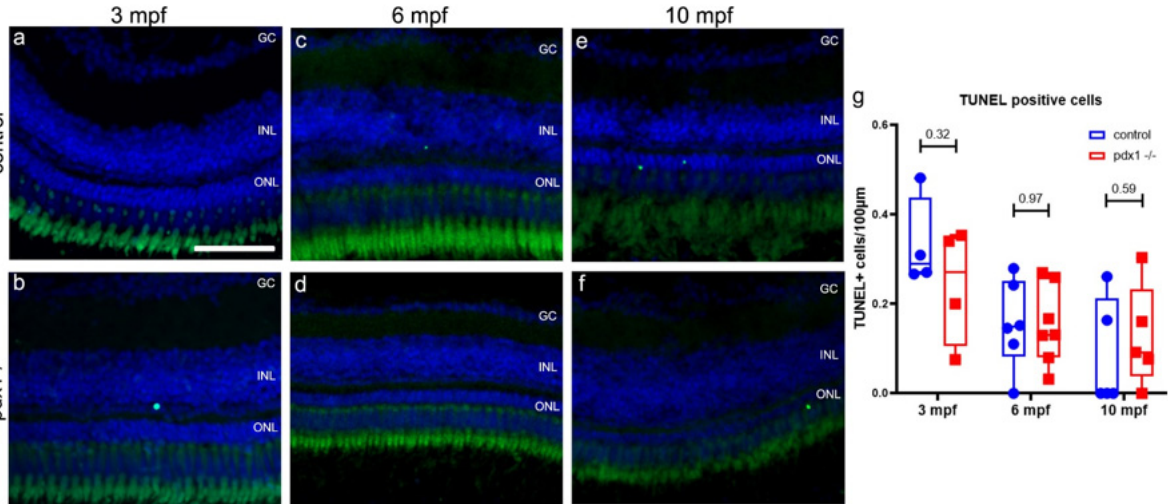
Figure 2. Hyperglycemia does not lead to increased cell death in the neural retina of pdx1 − / − mutants. Cryosections of retina at 3 ( a , b ), 6 ( c , d ) and 10 ( e , f ) mpf from control and pdx1 − / − mutants labeled by TUNEL staining (green) and counterstained with DAPI (blue). ( g ) Quantification of TUNEL positive nuclei in all layers of the retina. Box plot extends from 75% to 25%, showing all data points, line indicates median, n = 4–7 fish per time point. Scale bar: 50 μ m. (GC, ganglion cell layer; INL, inner nuclear layer; ONL, outer nuclear layer).